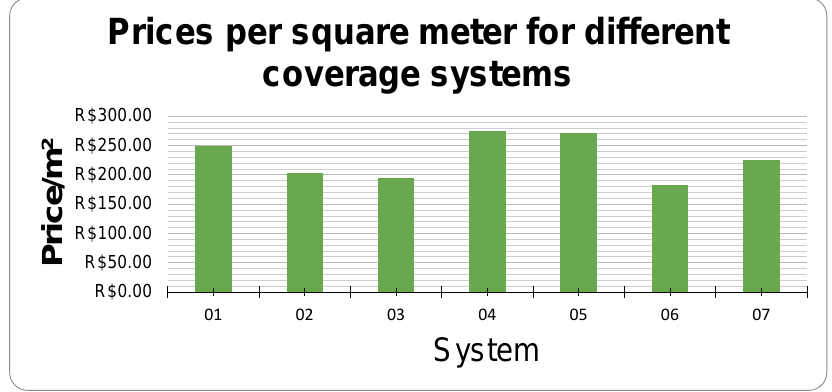
Fig. 5. Cost comparison of coverage systems (Savi,